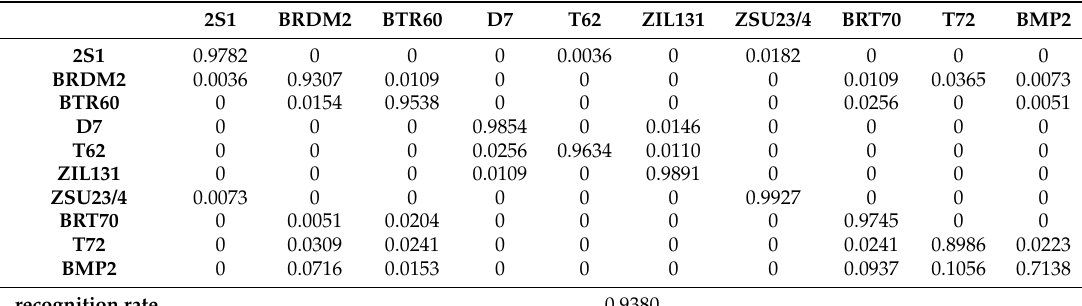
Table 9. The result of SDDLSR based on the wavelet decomposition image under SOC.